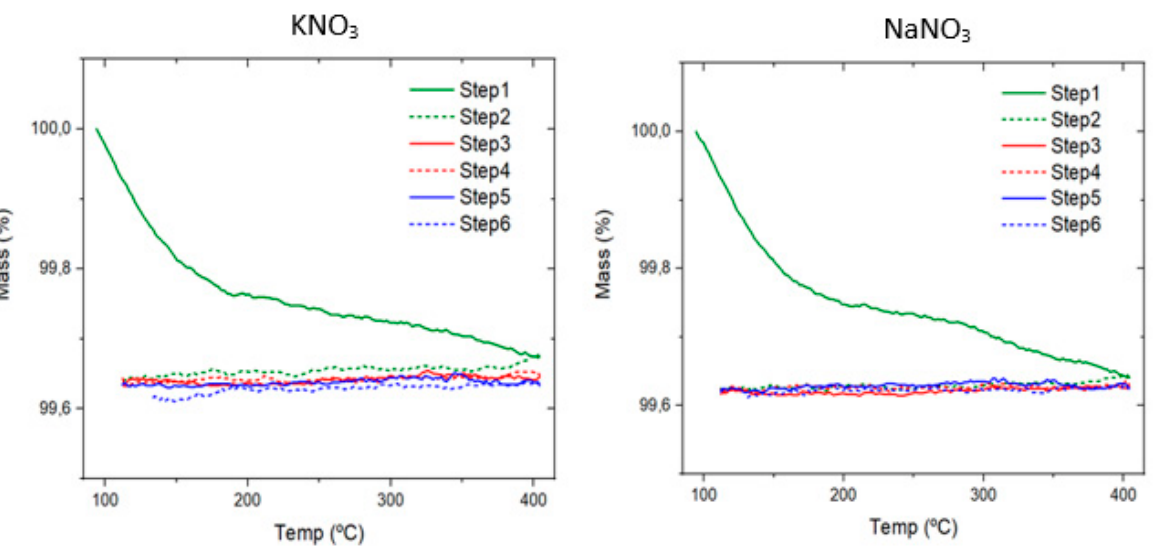
Figure 3. TGA curves for KNO 3 and NaNO 3 between 100 and 400 ◦